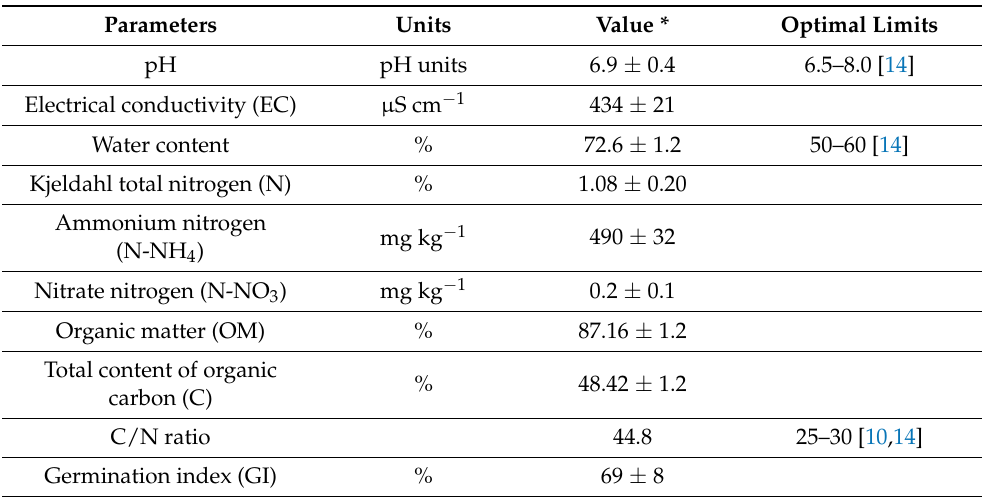
* Data expressed as mean ± standard deviation ( n = 3).